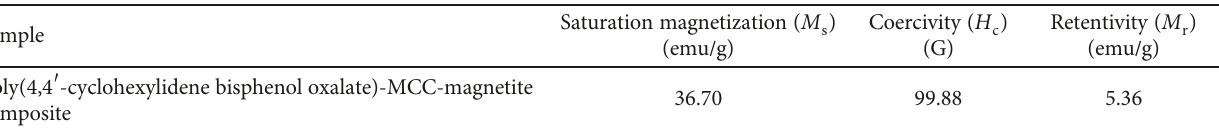
Table 3: The values of saturation magnetization ( M magnetite